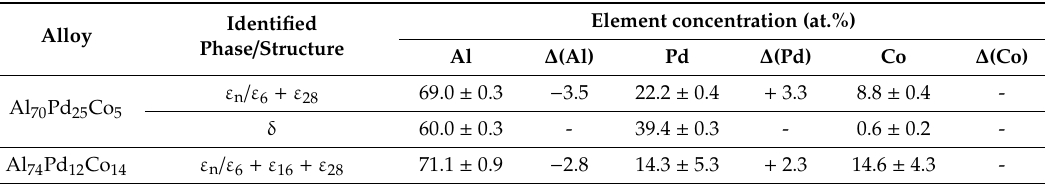
Table 4. Metal concentrations and phase assignments of the as-polarized Al–Pd–Co alloys. Di ff erences in metal concentrations between as-polarized and as-solidified alloys are also presented (compare with data in Table